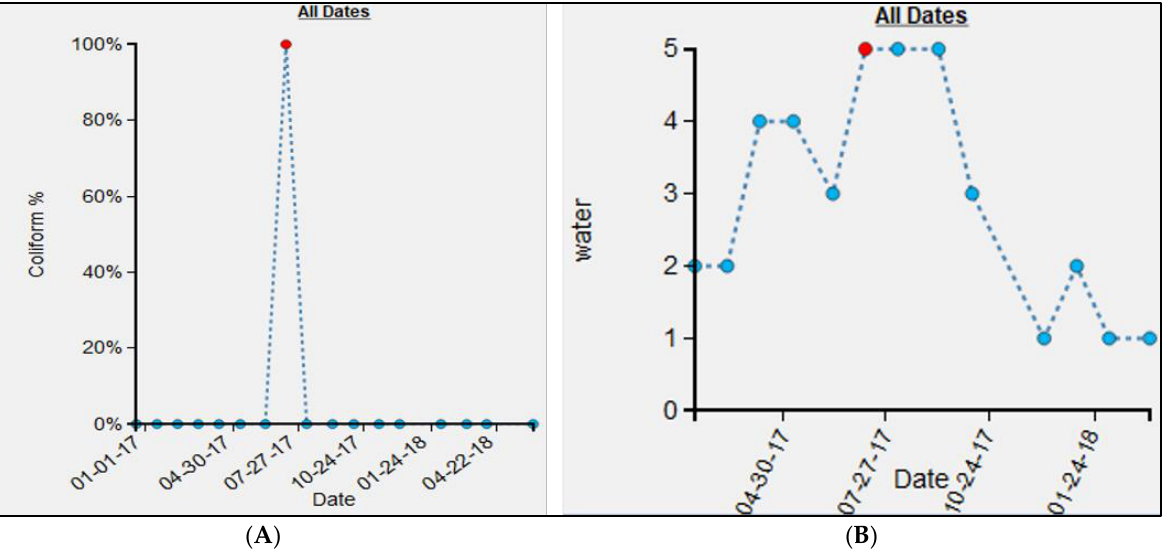
Figure 8. Epidemiological and environmental record for M13 water point: ( A ) time-chart for FC count, ( B ) time-chart for the environmental variable water.